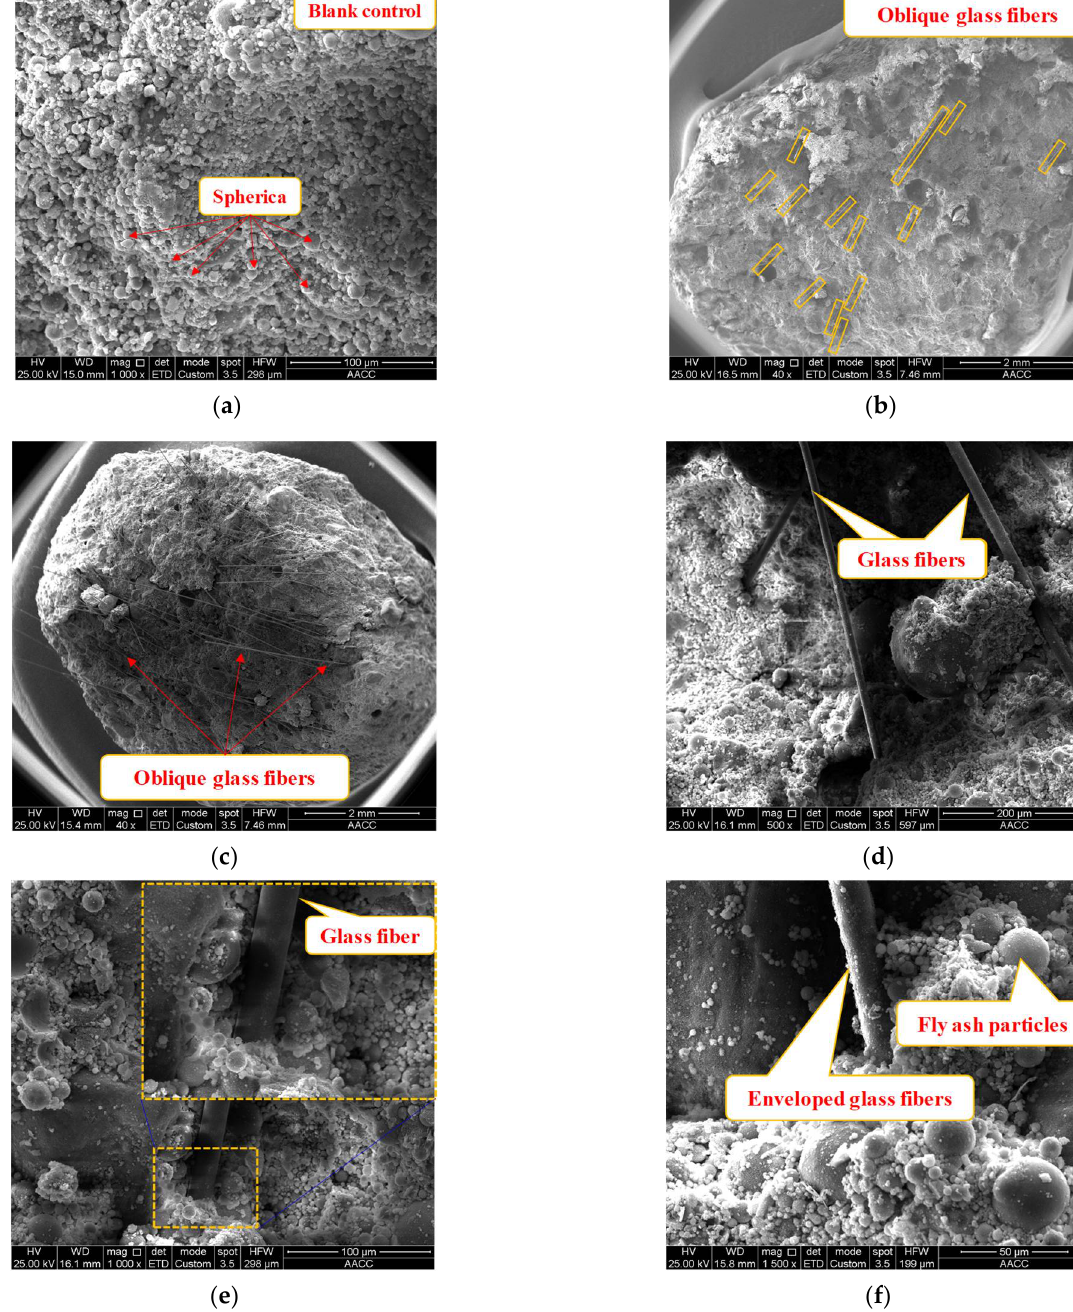
Figure 16. Matrix-glass fiber adhesion features during shear tests under different magnifications. ( a ) Blank control; ( b ) Distribution features of shear angles ×1000; ( c ) ×40; ( d ) ×500; ( e ) ×1000; ( f ) ×1500.